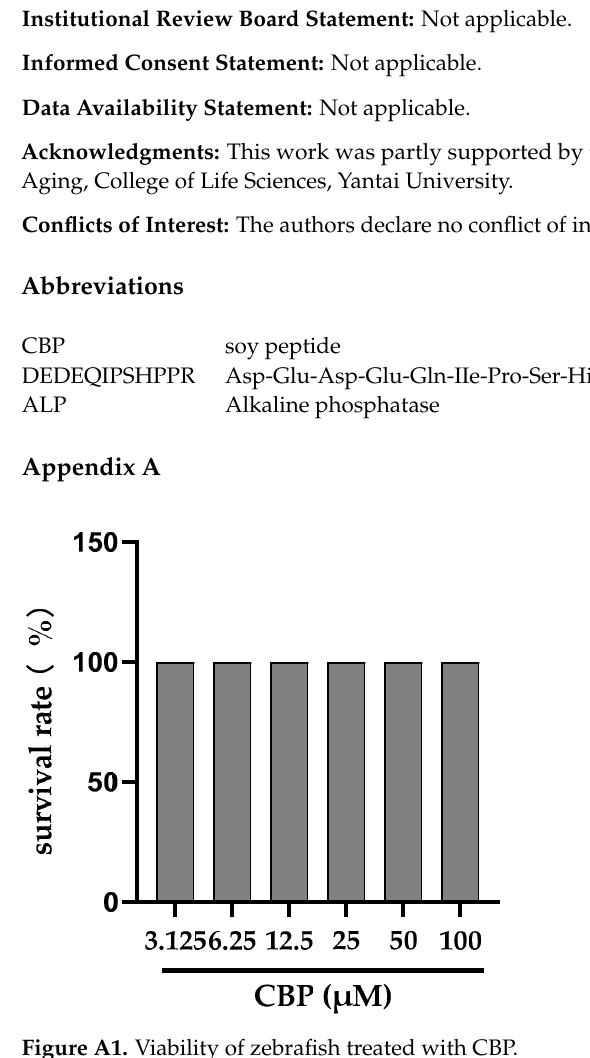
Figure A1. Viability of zebrafish treated with CBP.